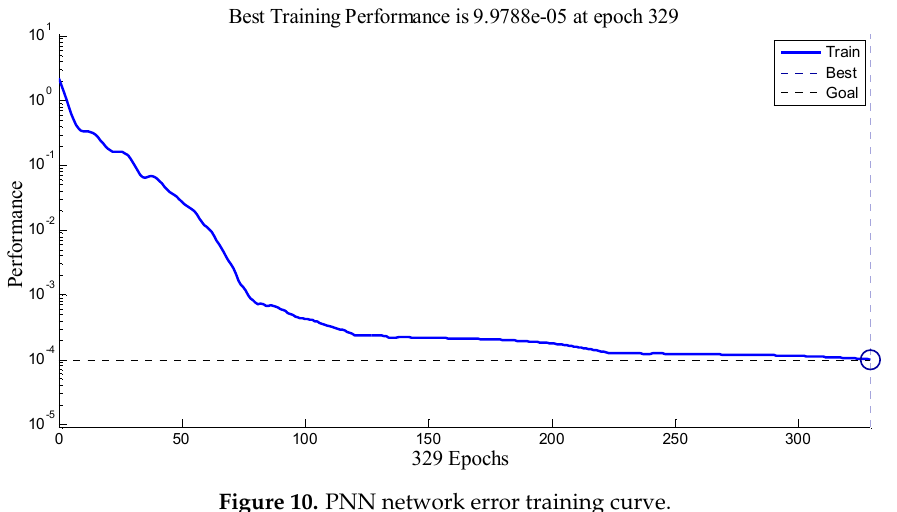
Figure 10. PNN network error training curve.